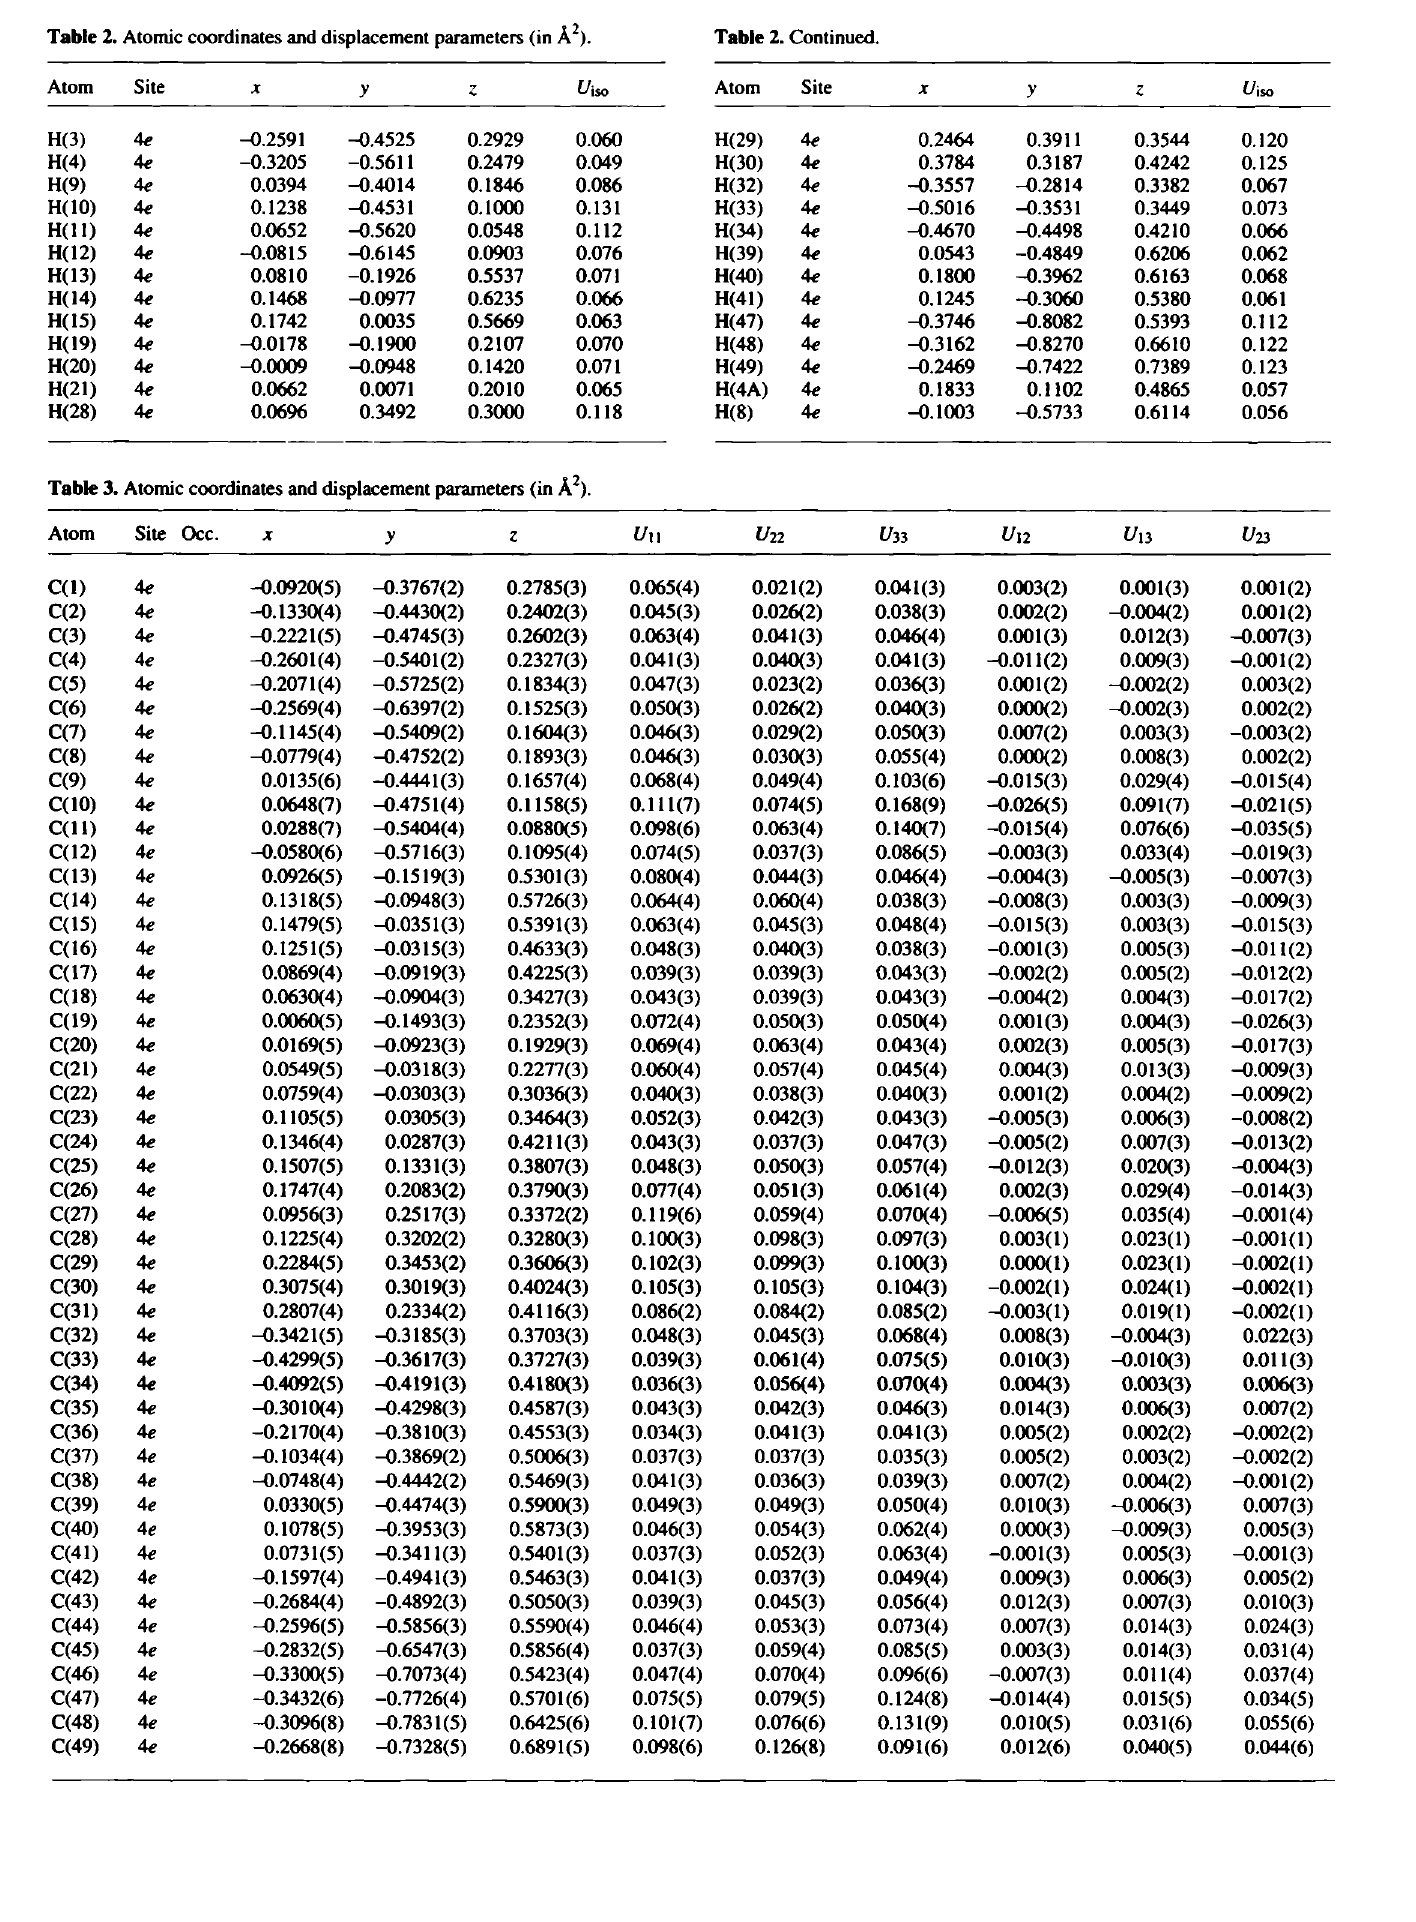
Table 2. Atomic coordinates and displacement parameters (in A 2 ).